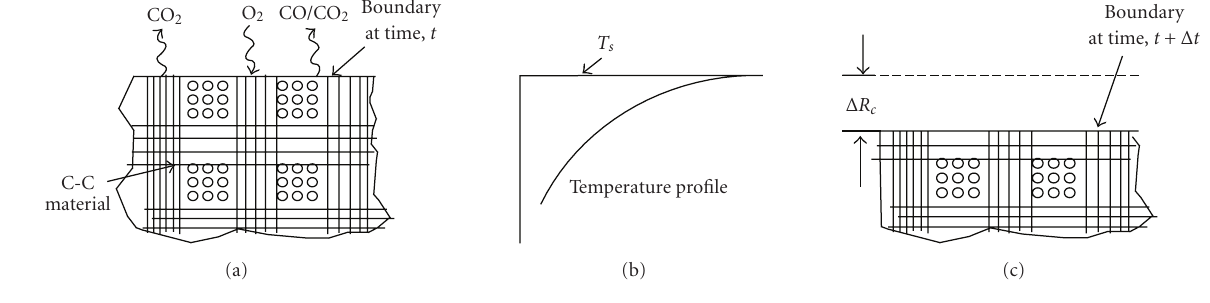
Figure 3: Chemical ablation and boundary movement.